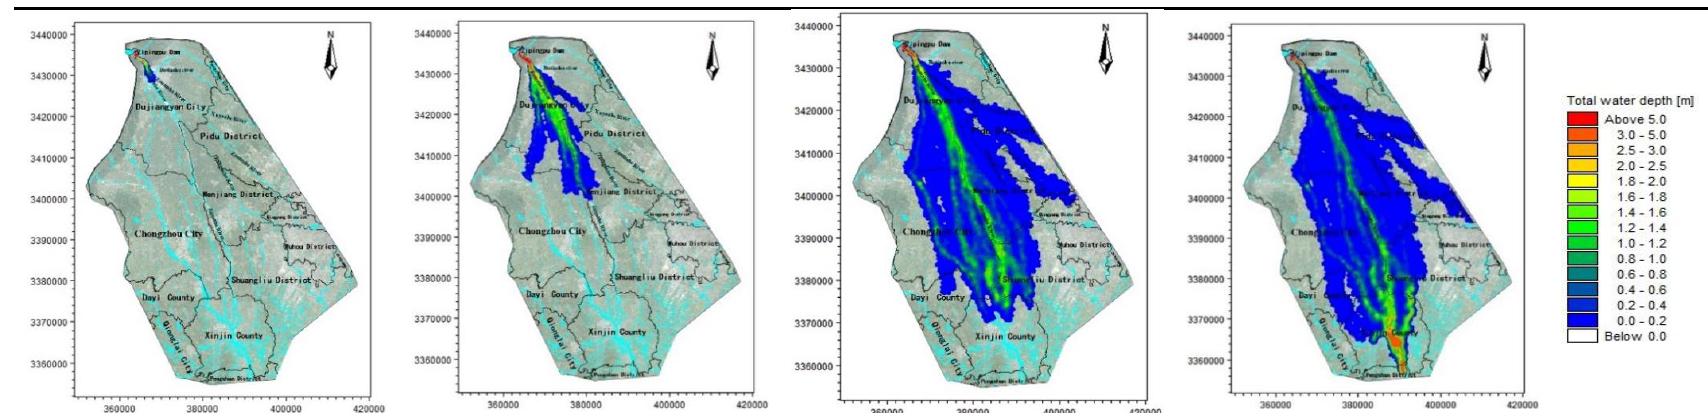
Figure 4. Scenario 2: Inundation at four time points.